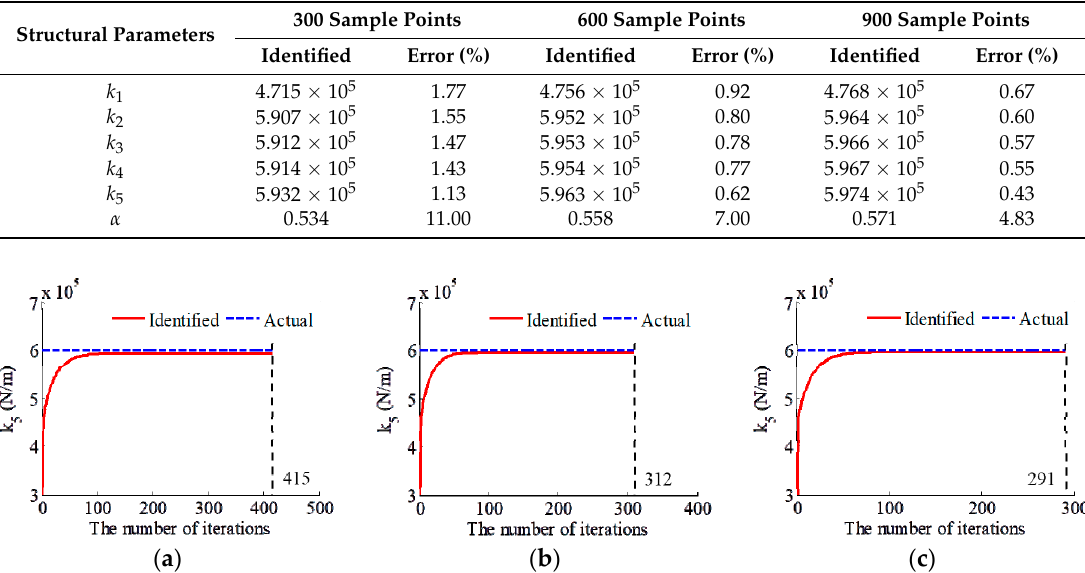
Table 2. Identified structural parameters with different numbers of sample points.